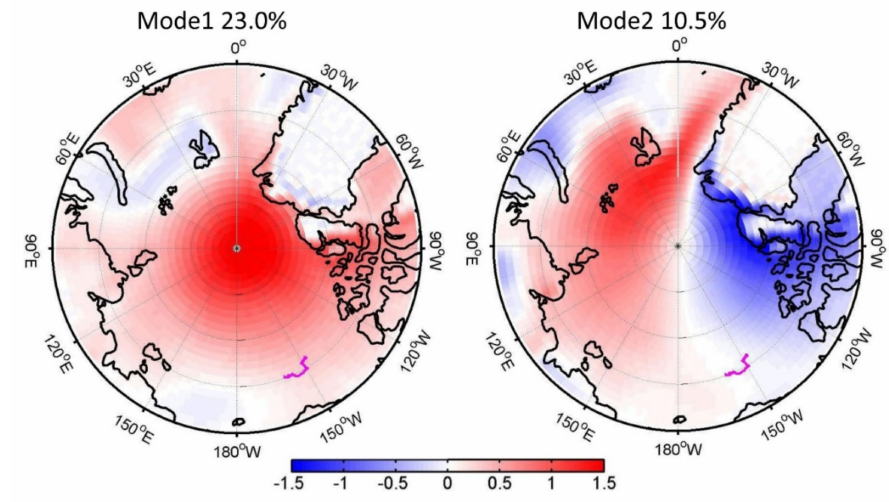
Figure 8. Spatial patterns of the first two modes of the Empirical Orthogonal Function (EOF) analysis of the wintertime 10–60-day filtered temperature di ff erences between 850 and 950 hPa (units: ◦ C) for the 1979–2017 period. The pink lines denote the track of the SHEBA campaign during January